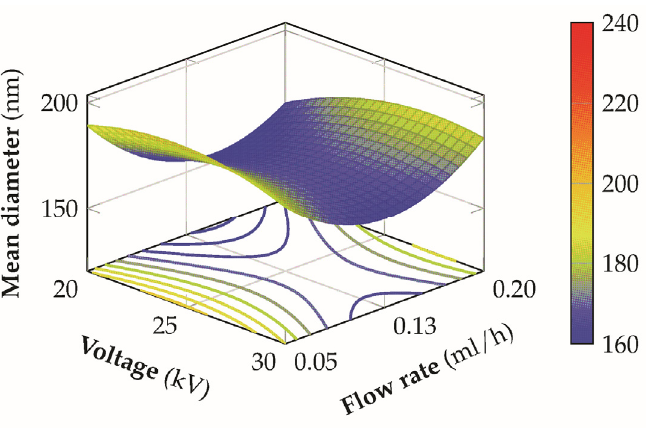
Figure 10. 3D response surface of the mean diameter for the voltage versus flow rate at a sulfonation degree of 70% and a distance of 14 cm from the tip to the